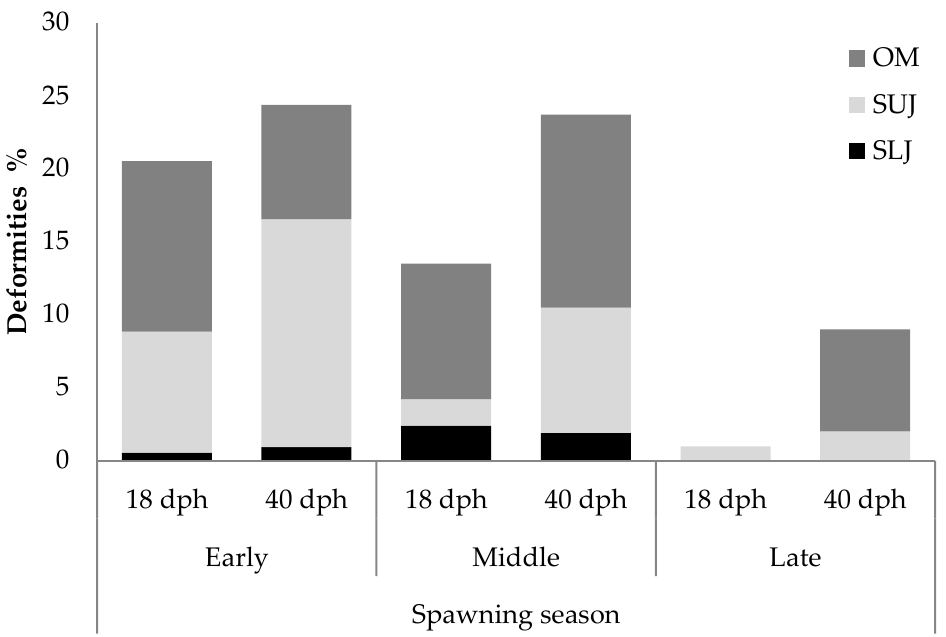
Figure 4. Quantification of normal and deformed phenotypes in 18 dph larvae and 40 dph juvenile Figure 4. Quanti fi cation of normal and deformed phenotypes in 18 dph larvae and 40 dph juvenile fish. OM, open mouth; SUJ, short upper jaw; SLJ, short lower fi sh. OM, open mouth; SUJ, short upper jaw; SLJ, short lower jaw.